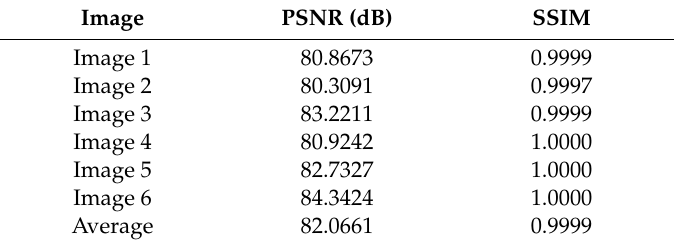
Table 2. Peak signal to noise ratio (PSNR) and structural similarity image index (SSIM).